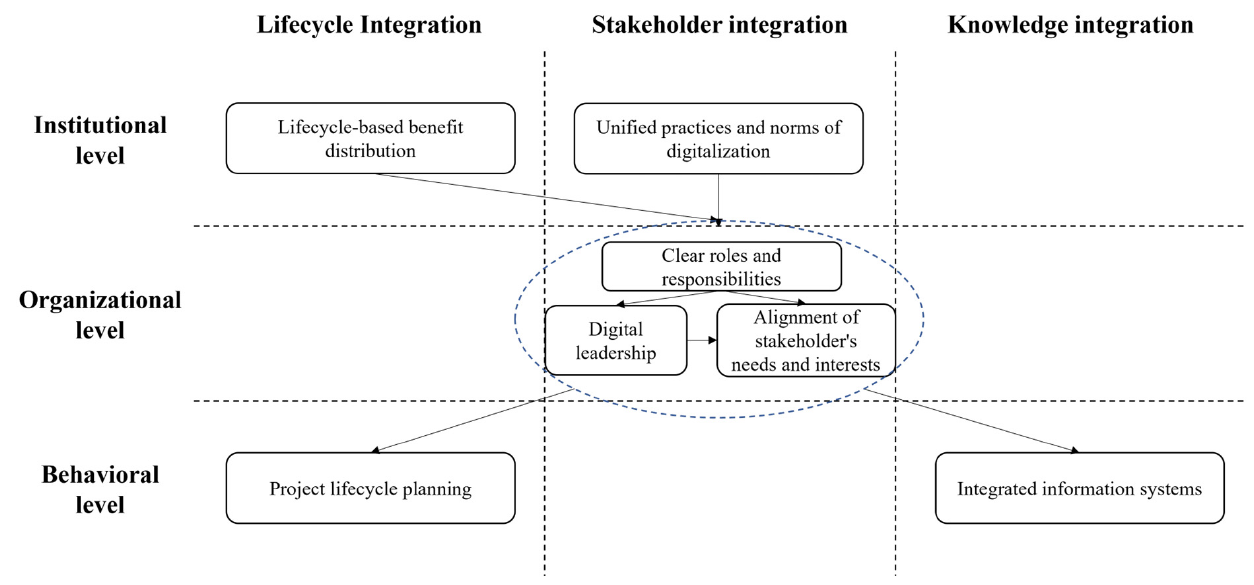
Figure 3. Project governance model for integration in digitalization of construction projects.